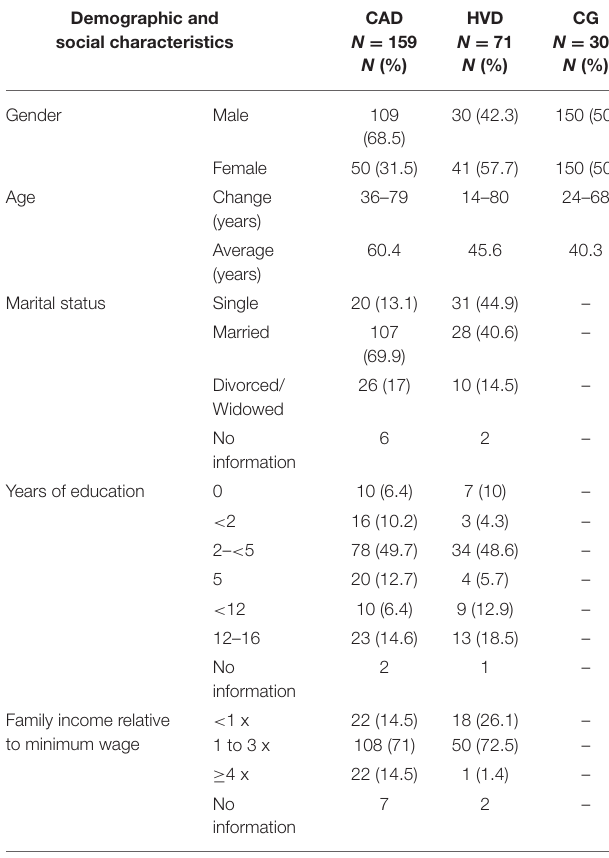
TABLE 1 | Demographic and social characteristics of cardiac patients (CAD and HVD) investigated. Demographic and social